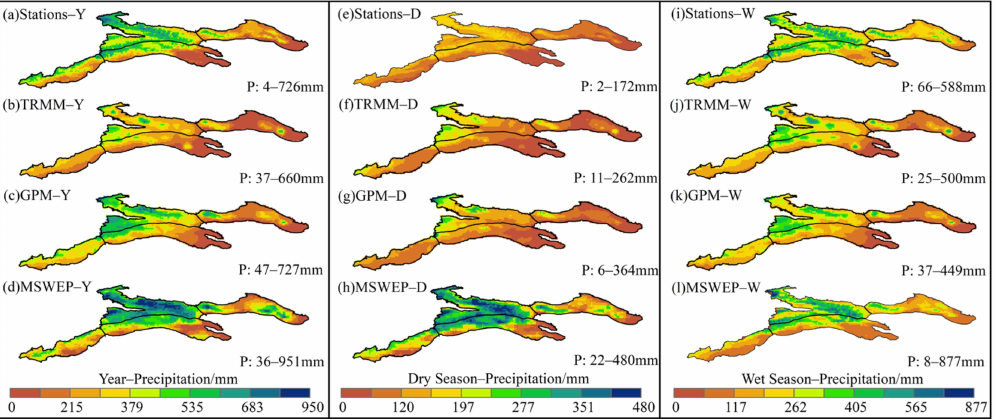
Figure 8. Spatial distribution of precipitation in station interpolation ( a , e , i ), TRMM ( b , f , j ), GPM ( c , g , k ) and MSWEP ( d , h , l ). Annual scale ( a – d ); Dry season ( e – h ); Wet season ( i – l ).